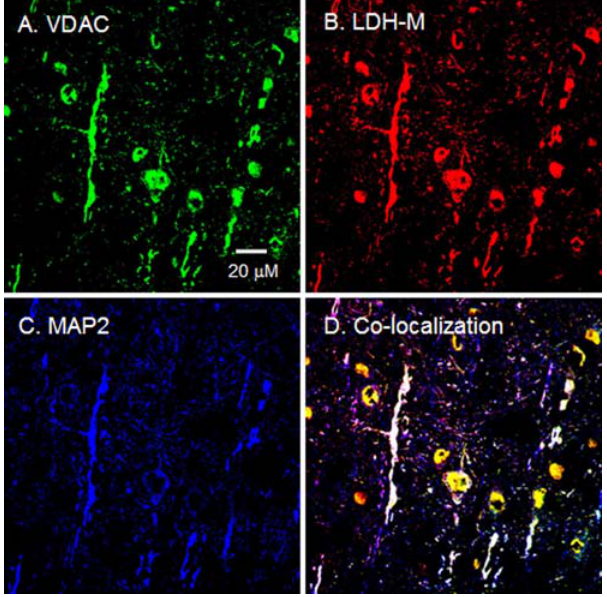
Figure 5. Immunohistochemical images of rat brain demon- strating mitochondrial LDH-M in cortical neurons. When signals from probes for LDH-M (B, red) and the mitochondrial protein VDAC (A, green) were merged with those for the neuronal marker MAP2 (C, blue), superposition of the signals (D, yellow/white) showed colocalization of LDH-M and components of the mitochondrial reticulum. Scale bar=20 m m.